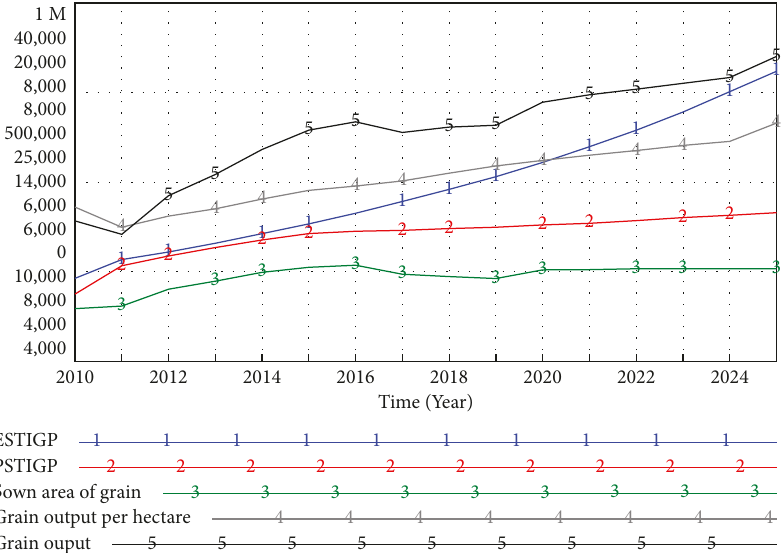
Figure 5: Trend chart of system simulation results from 2010 to